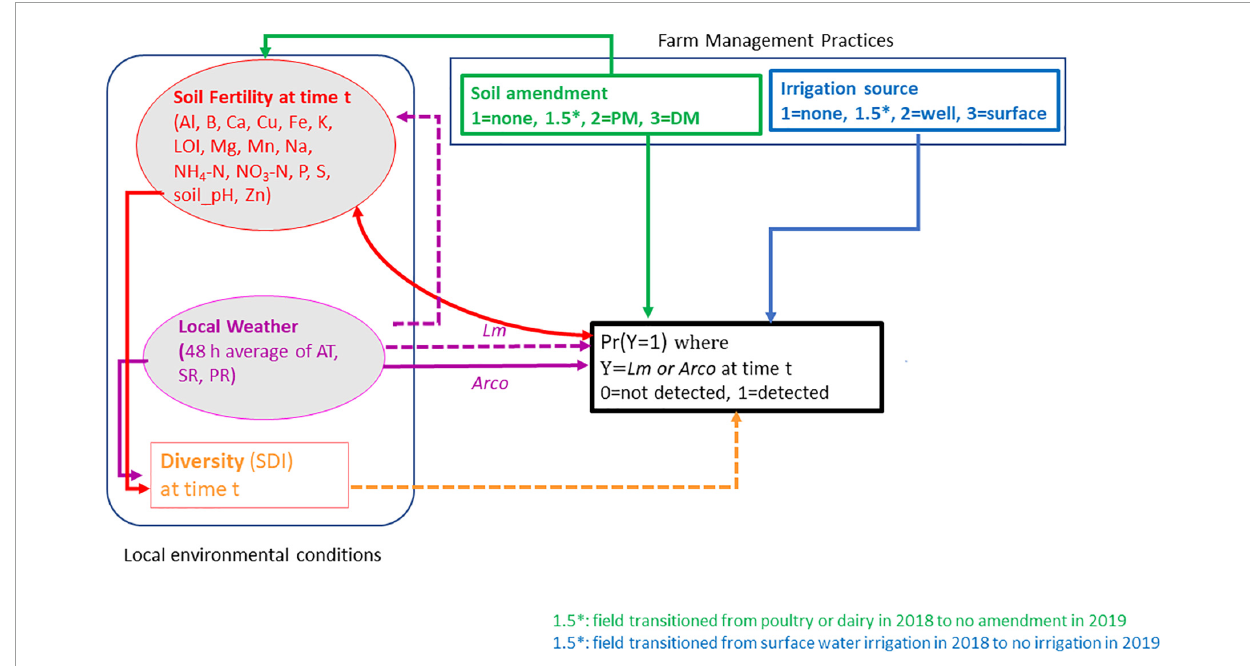
FIGURE1 Conceptual model for Lm and Arcobacter ( Arco ) prevalence in OH soil. Square boxes are observed variables, Farm management practices (soil amendment and irrigation source) and Simpson’s diversity index (SDI). Ovals are latent variables, soil fertility and local weather at time t. Arrows represent the flow of causality. Solid-line arrows indicate positive effects on the to variable, dash-line arrows indicate negative effects on the to variable. Double-headed curved arrows are covariances (i.e., no causality). Al, aluminum; B, boron; Ca, calcium; Cu, copper; Fe, iron; K, potassium; Mg, magnesium; Mn, manganese; Na, sodium; P, phosphorus; S, sulfur; Zn, zinc; LOI, loss-on-ignition; PM, poultry manure; DM, dairy manure; AT, air temperature; SR, solar radiation; PR,